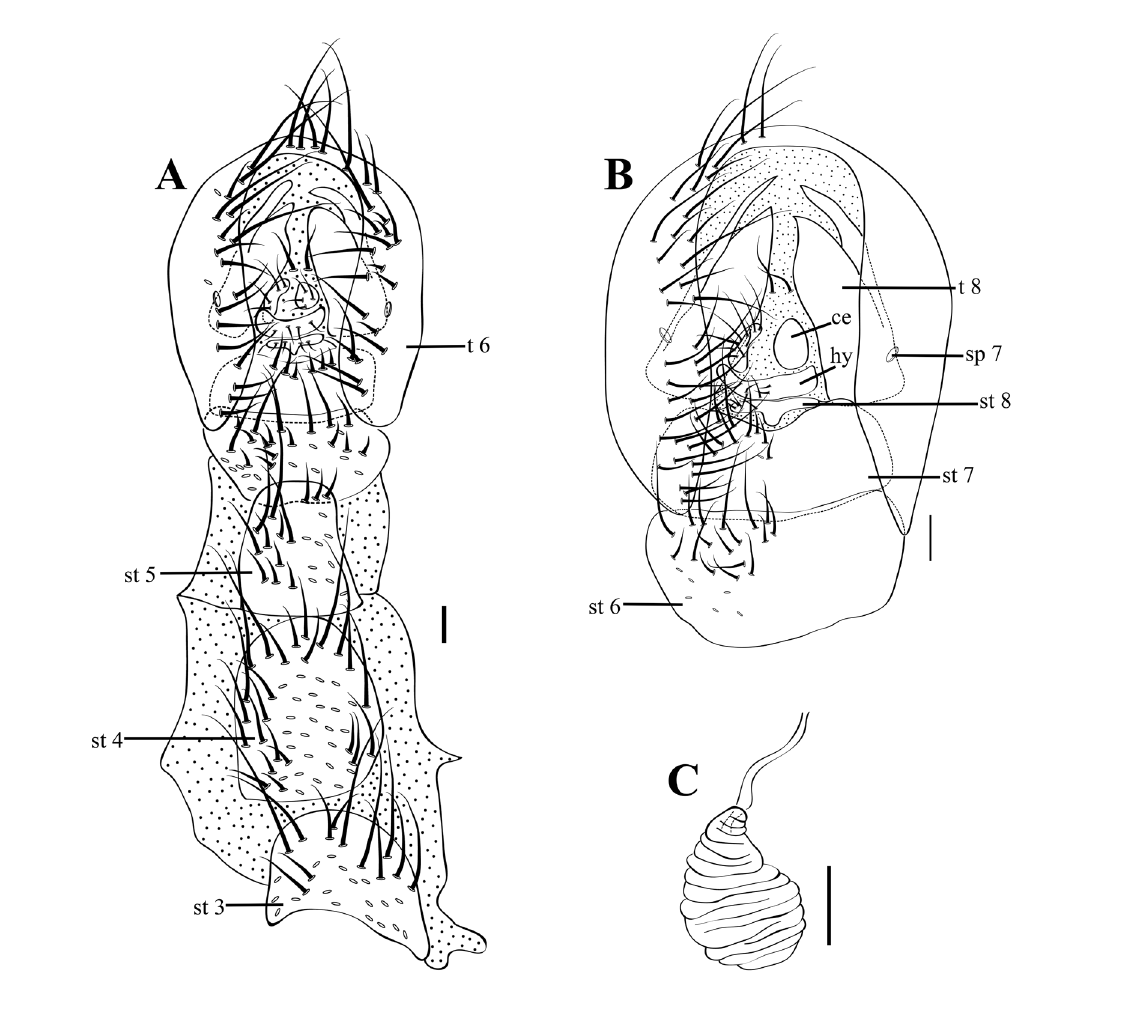
Fig. 2. Dexosarcophaga phoenix sp. nov., ♀, paratype (MNRJ [lost]), Brazil, Minas Gerais, Nova Lima, Lagoa Grande. A . Terminalia and abdominal sternites, ventral view. B . Terminalia, ventral view. C . Spermatheca, lateral view. Abbreviations: see Material and methods. Scale bars = 0.1